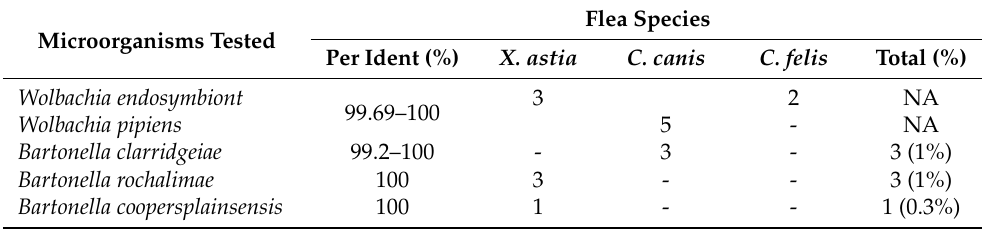
Table 4. Microorganisms detected using sequencing in fleas.